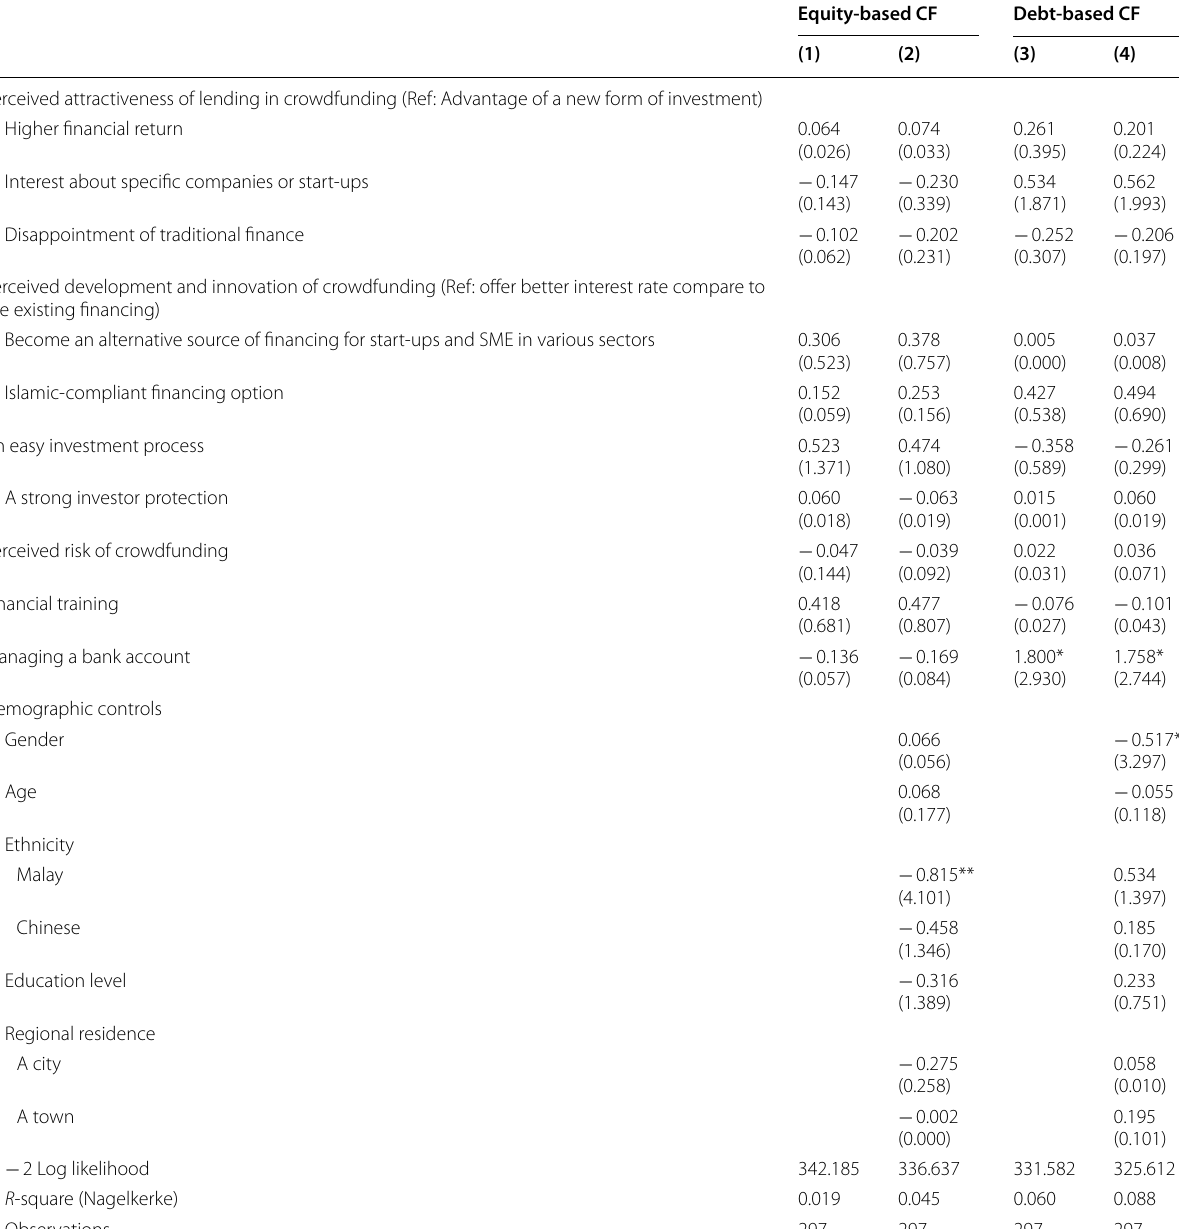
Table 5 Preference for a crowdfunding